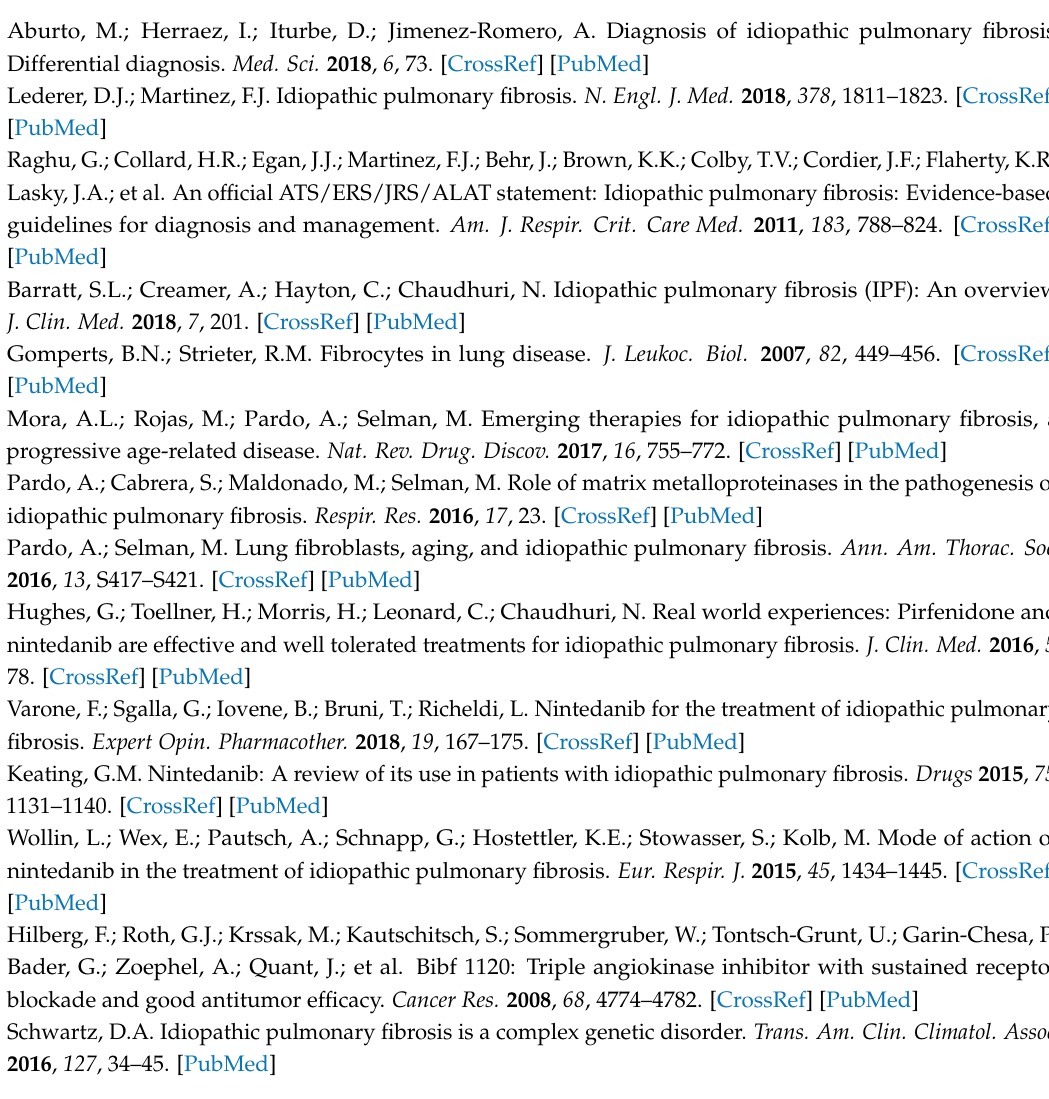
Table S1: The primers used in RT-qPCR, Table S2: Dysregulated genes in nintedanib-treated IPF fibroblast, Table S3: Possible binding sites of the 5 potential miRNA–mRNA